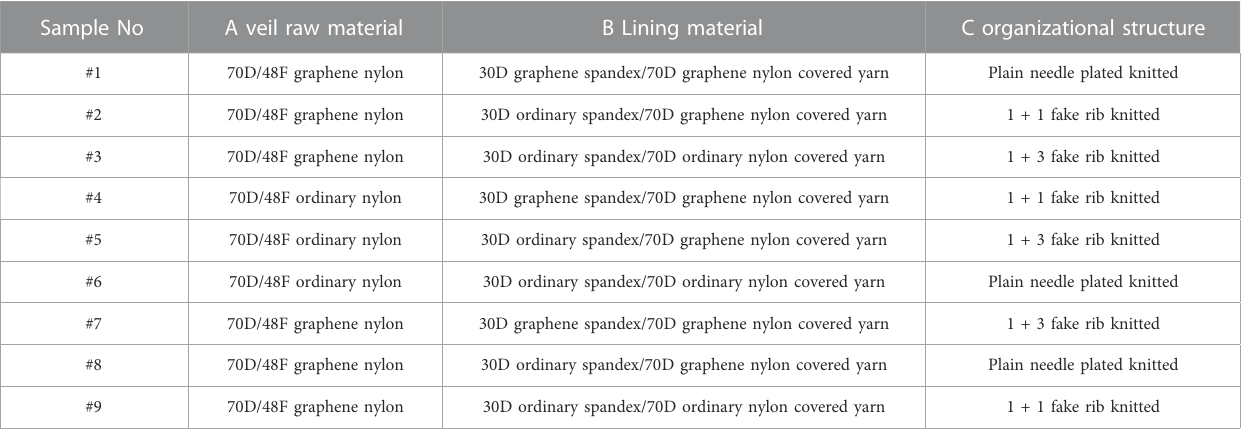
TABLE 2 Speci fi cations of each experimental sample.